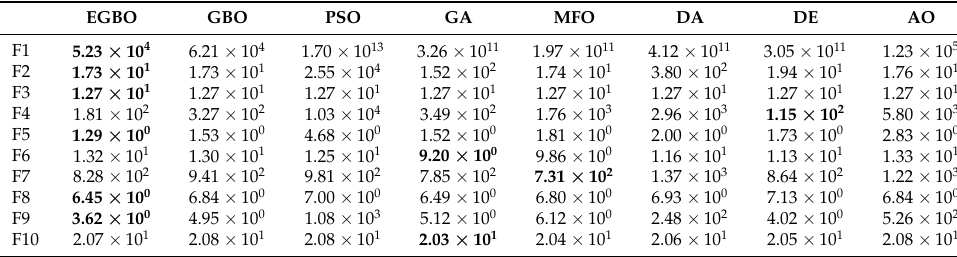
Table 3. Results of the max measure of the fitness function values.